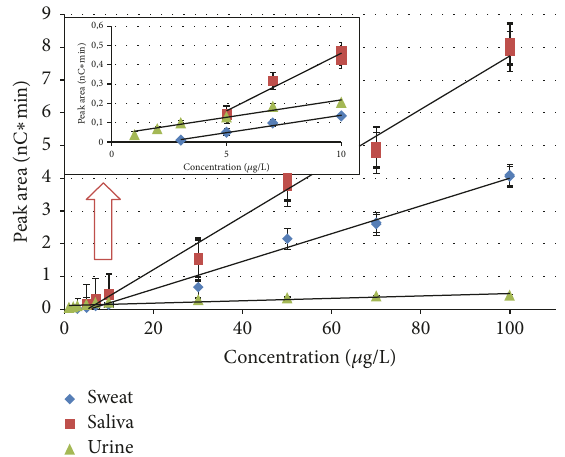
Figure 5: Ion chromatography calibration curves for cyanide ion analyzed in biological samples.